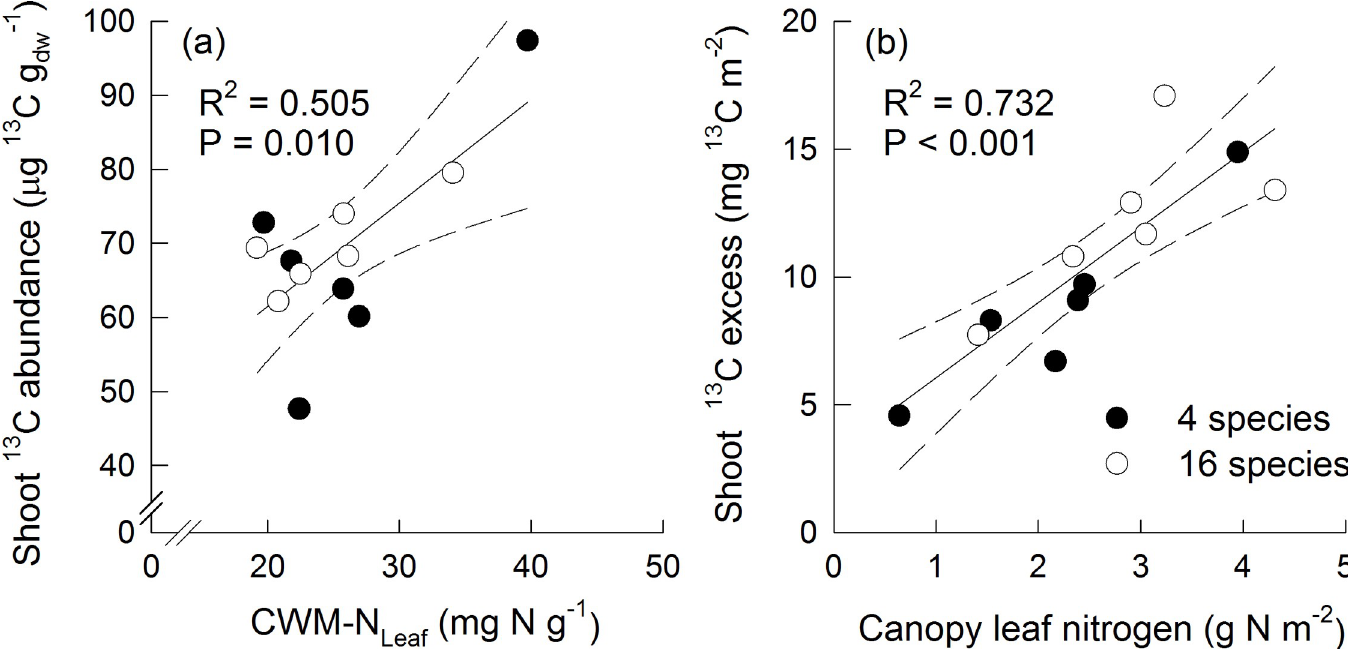
Fig 2. Relationships between community-level 13 C abundance in shoot biomass and biomass-weighted means of leaf nitrogen concentrations (a), and relationships between community-level shoot 13 C excess and canopy leaf nitrogen per unit soil surface (b). Closed circles display mixtures sown with 4 species, open circles display mixtures sown with 16